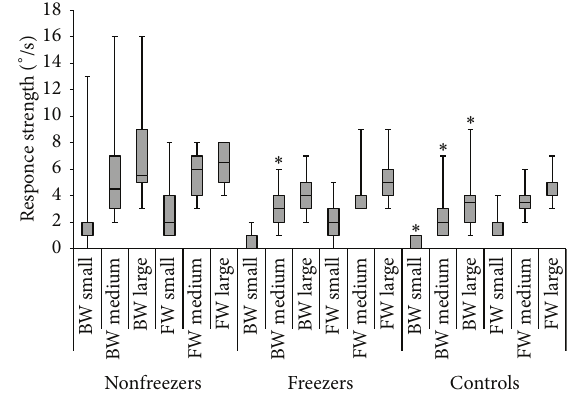
Figure 3: Group differences in MCT performance per condition. Response strength of the left leg in forward (FW) and backward (BW) translations for small, medium, and large conditions sepa- rately.Boxesrepresentmedianvaluesandinterquartileranges(Q25– Q75) with error bars indicating range. ∗ Significant difference ( 𝑃 < 0.05 ) with nonfreezers (post hoc).